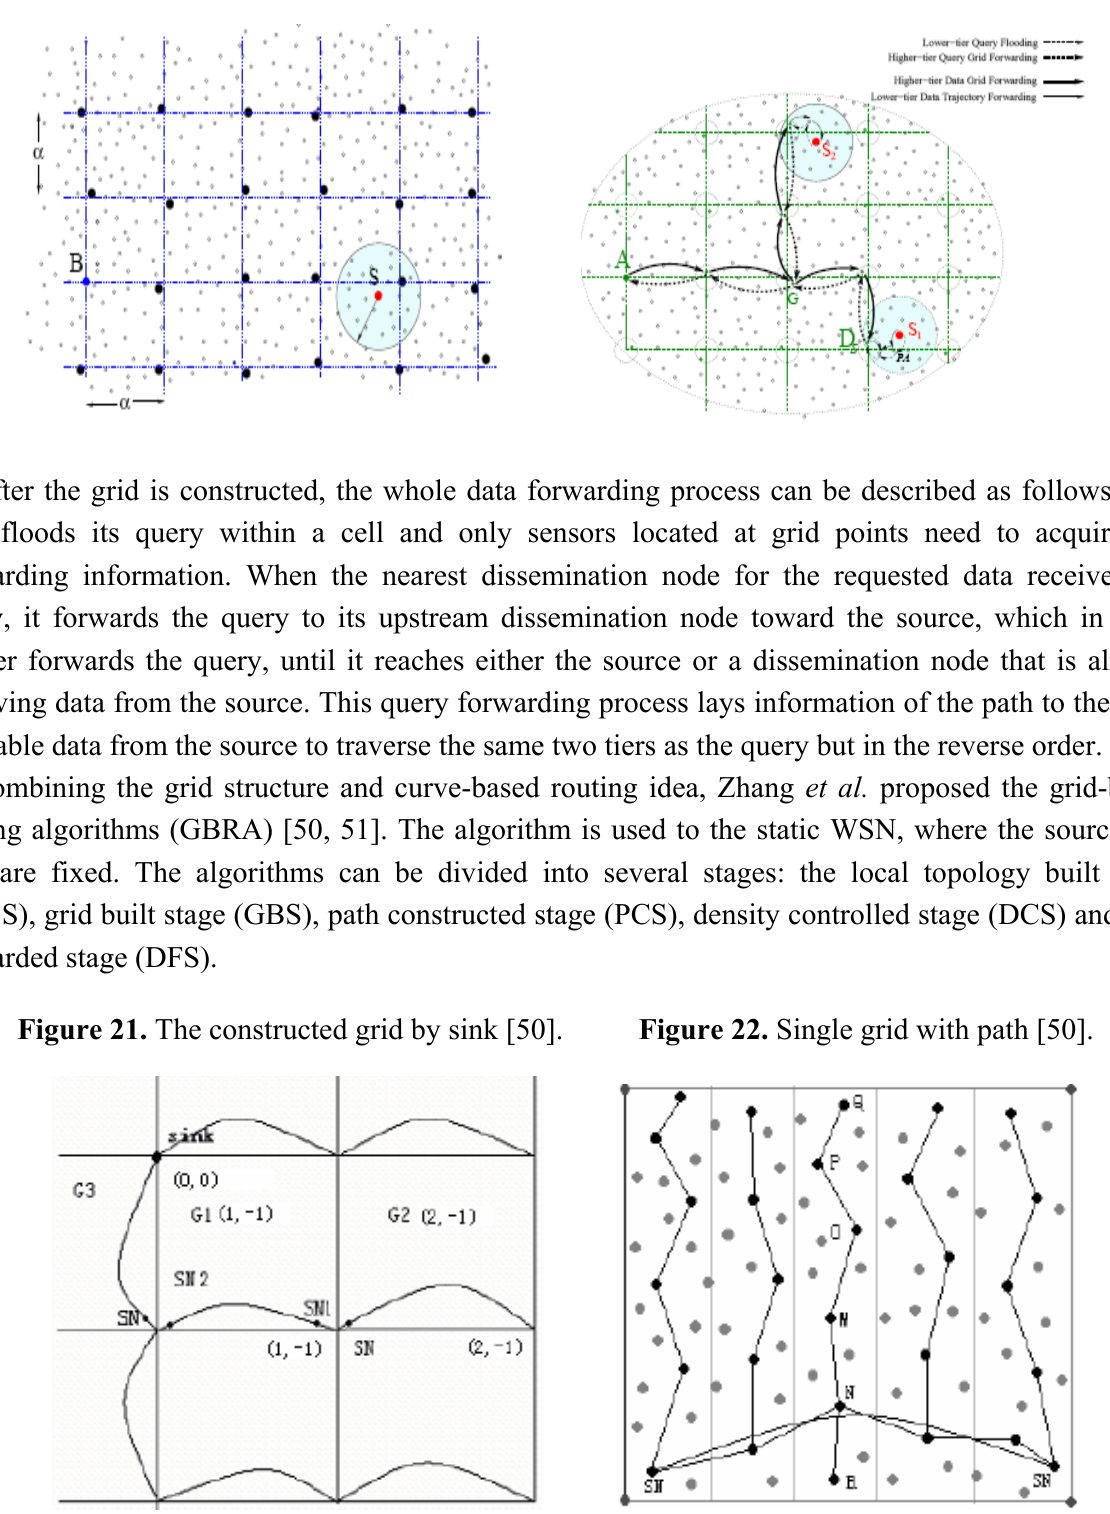
Figure 19. The grid constructed by B [49]. Figure 20. Query and data forwarding [49].